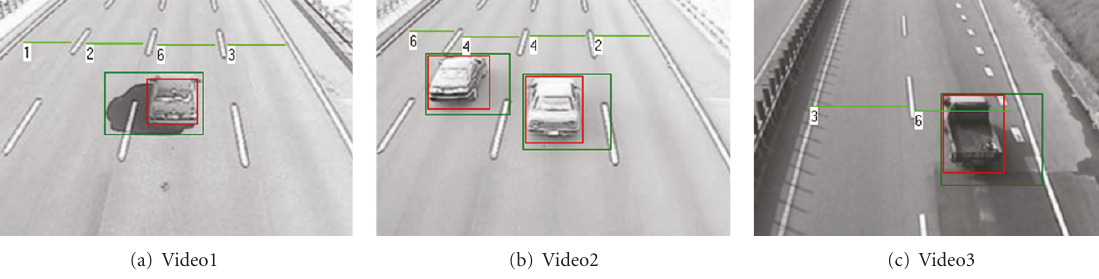
Figure 32: Scenes of videos for vehicle counting.